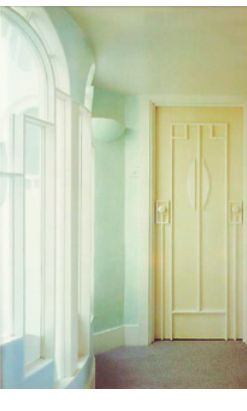
Fig. 32. Charles A. Jencks. Thematic House. London, 1982–1985 (Jencks 1985: 200)